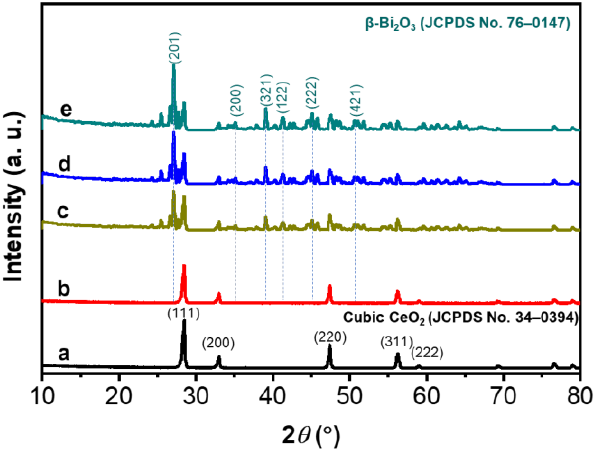
Figure 1. XRD patterns of the produced powders representing the crystallization of pure CeO 2 (as labeled in a compared with 5, 10, 15, and 20% Bi 2 O 3 /CeO 2 as represented by b , c , d , and e , respec- tively.